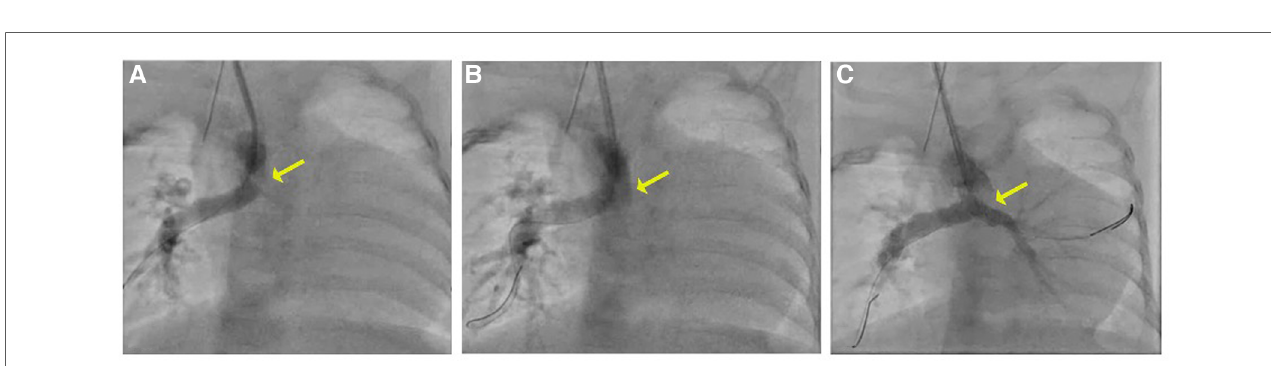
FIGURE 2 ( A ) Angiogram with a 4 Fr Glide catheter via the right carotid artery sheath demonstrates thrombus in the mid-to-distal central shunt (yellow arrow) and no contrast seen in the LPA. ( B , C ) On serial angiography following mechanical thrombectomy, the area of lucency is no longer present and there is improved fl ow in the